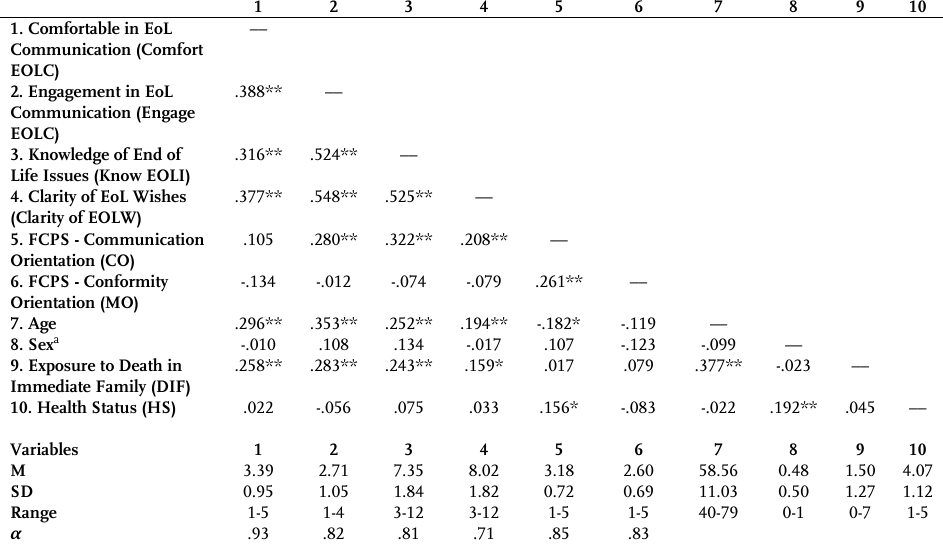
Table 1 : Correlations among the parameters included in multiple regression for analyses